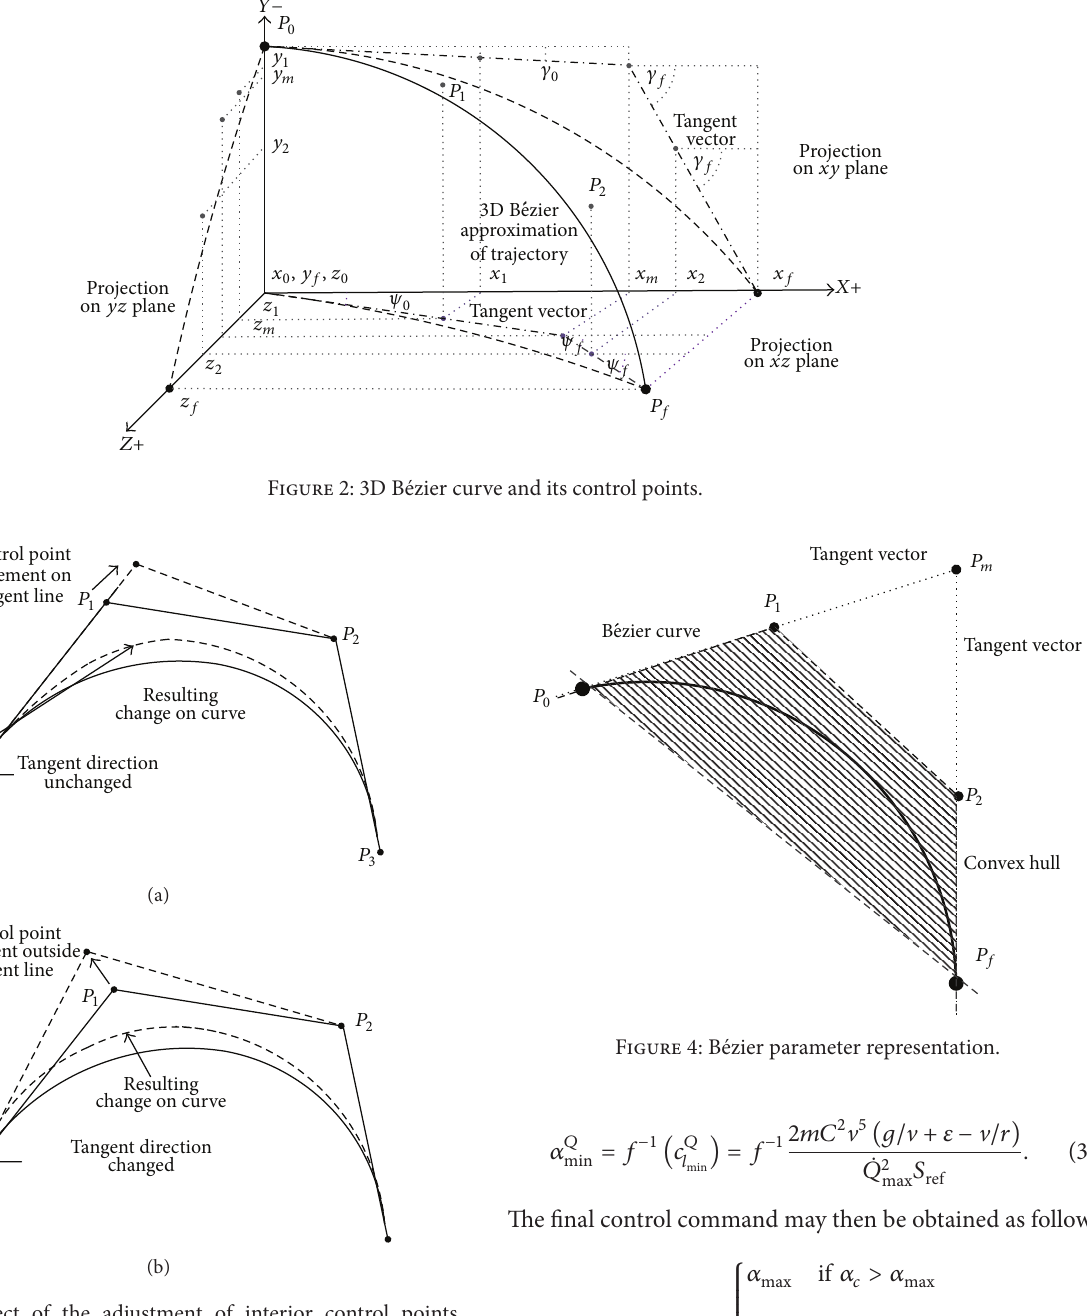
Figure 3: Effect of the adjustment of interior control points. Direction of the tangent of the curve at the initial control point remains unchanged if the interior control point is adjusted on the same tangent line. Moving the control point outside of the tangent line changes the tangent and its direction.